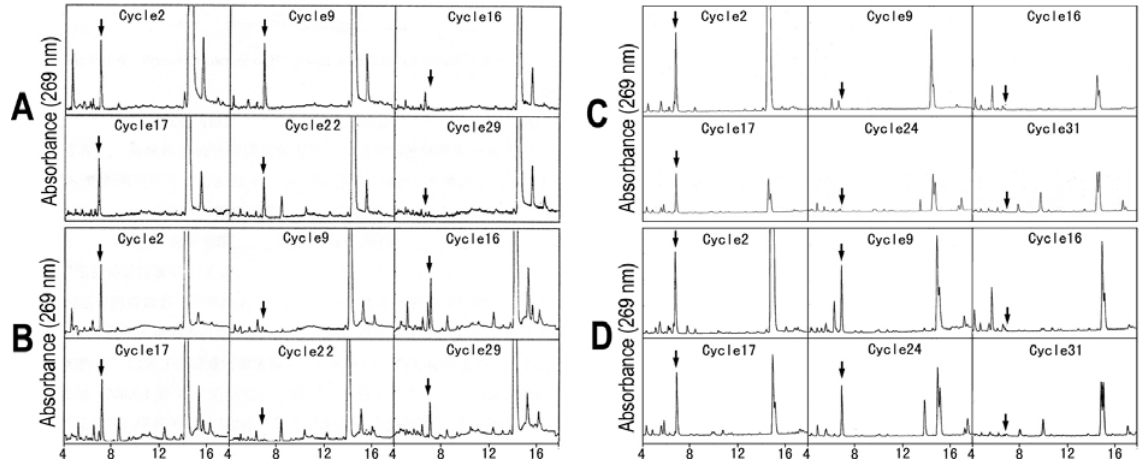
Figure 3. HPLC profiles of cysteine cycles of sequencing alkylated intermediates of HNTX-III and HNTX-IV. The elution position of Pth-CM-Cys is marked with arrows. The cycles of cysteine residues in peak Ia and Ib of HNTX-III ( A , B ). The cycles of cysteine residues in alkylated peak II and Ia of HNTX-IV ( C , D ).